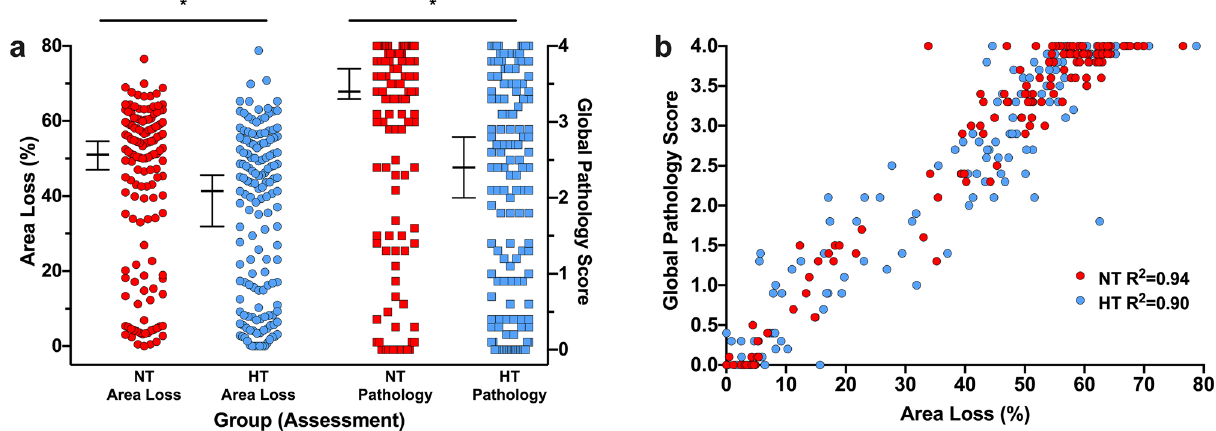
Figure 4. Comparison between area loss and global pathology score. ( a ) Direct comparison of area loss and pathology score in the n = 277 (n = 132 NT, n = 145 HT) animals that underwent pathology scoring, representing the median injury in the NT and HT groups within each litter from each experiment. Median (95% CI) area loss was 51.0% (47.0–54.6%) in the NT group, and 41.3% (31.6–45.6%) in the HT group, with corresponding global pathology scores of 3.4 (3.3–3.7) in the NT group, and 2.4 (2.0–2.8) in the HT group. This resulted in a 19.0% neuroprotection by HT, compared to 25% neuroprotection when comparing the same animals using global pathology score. The resulting ES for HT was 0.42 when using area loss, and 0.51 when using global pathology. ( b ) Global pathology score was linearly correlated with area loss in both the NT (R 2 = 0.94, p < 0.001) and HT (R 2 = 0.90) groups ( p < 0.001 for